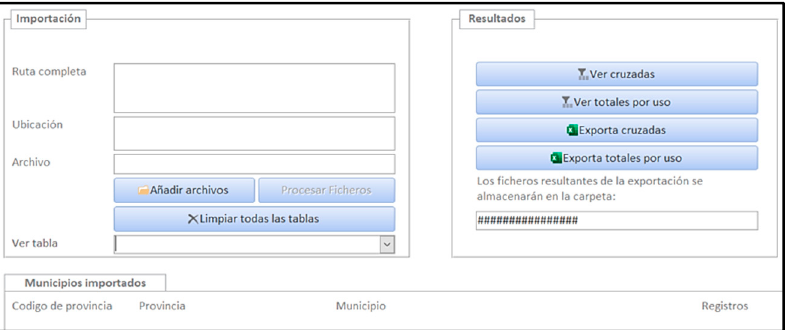
Figure 4. Interface of the application generated to process the CAT files. Source: own preparation.